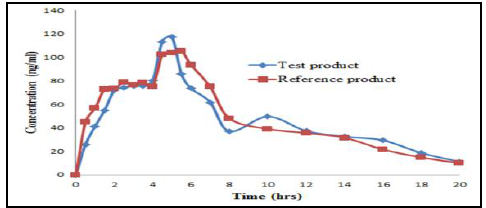
Figure(2): Mean plasma concentrations of pentoxifylline versus time after a single dose administration of a test formulation (extended- release tablet containing 400 mg pentoxifylline) and the reference formulation (Trental ® extended-release tablet containing 400 mg pentoxifylline) to 32 healthy male adult subjects under fed condition